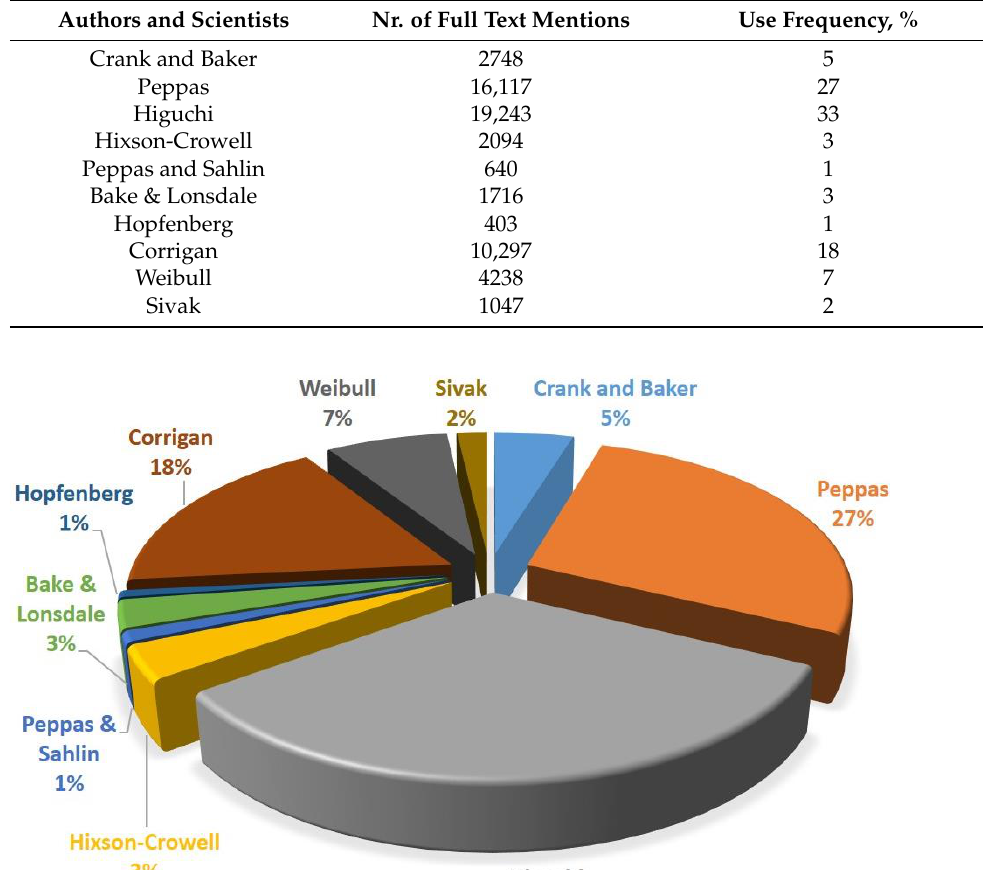
Table 1. Diffusion of specific authors’ and scientists’ models for drug release.